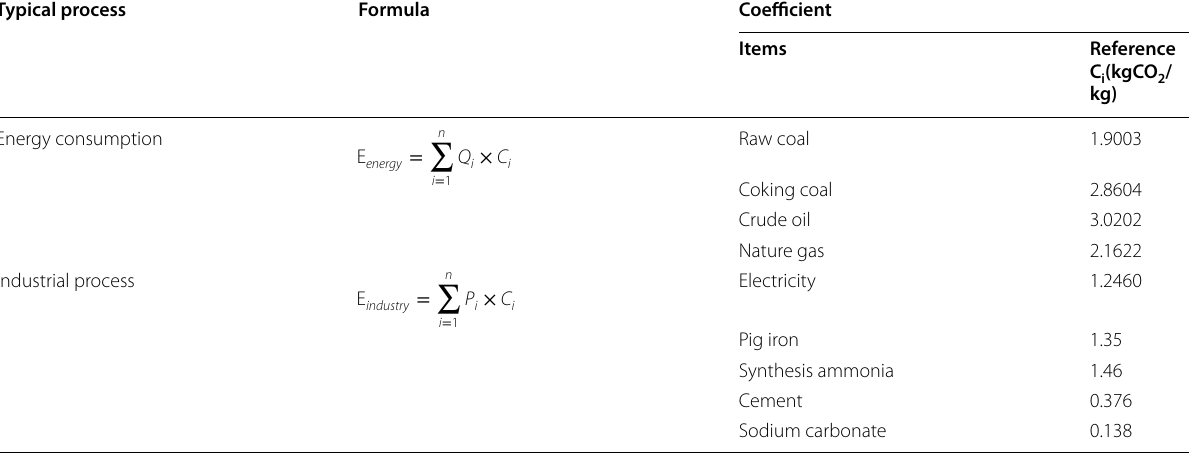
Table 1 The carbon emission calculation formula of energy and industrial process Typical